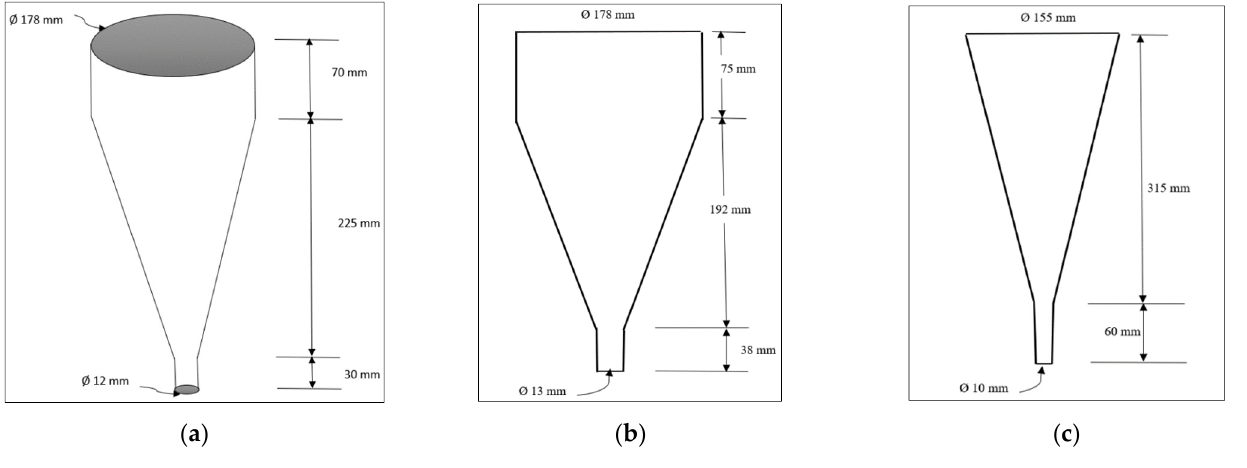
Figure 6. Flow cones with different geometries: ( a ) Malaysian flow cone ( b ) ASTM flow cone ( c ) Marsh flow cone (dimensions not-to-scale).